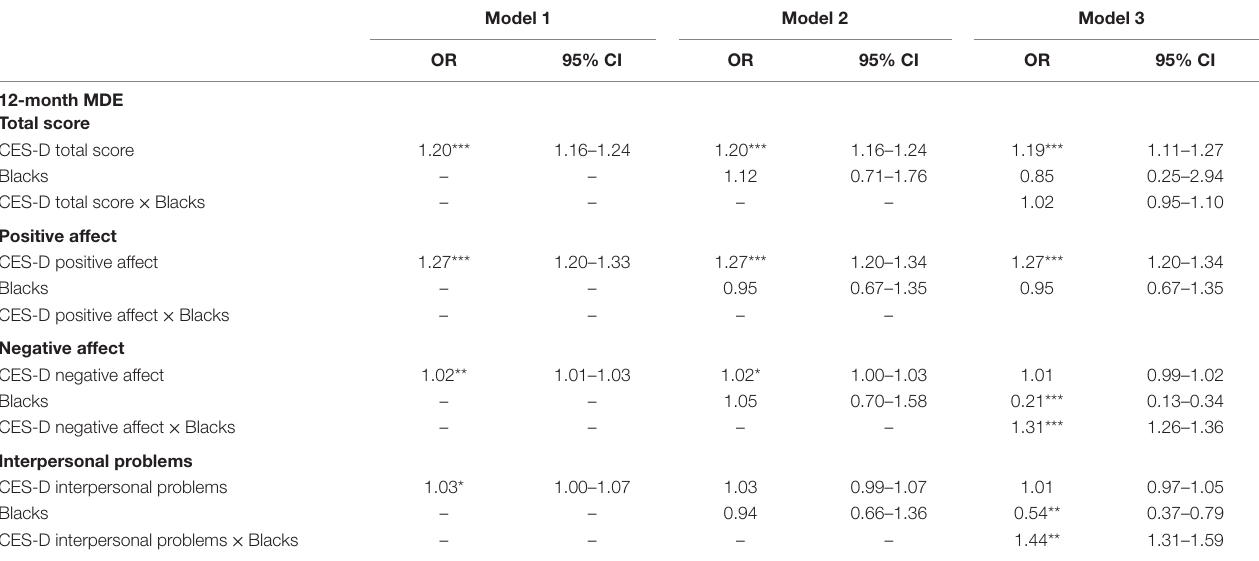
TaBle 4 | summary of regressions on the associations between ces-D factors and ethnicity on 12-month depressive disorders in the pooled